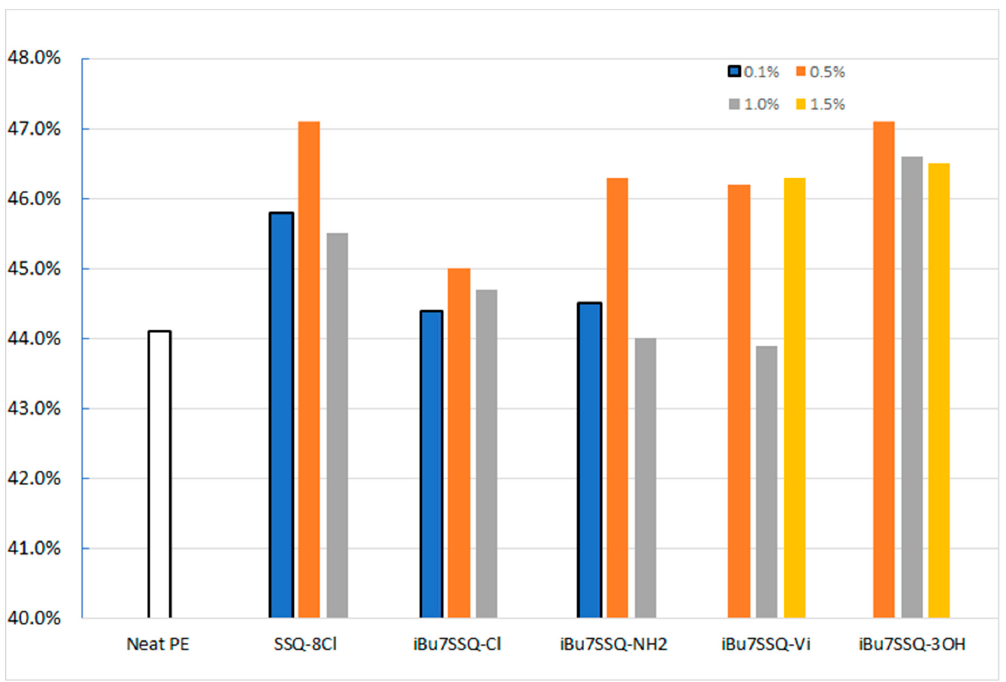
Figure 5. Crystallinity indices (CI) of the obtained composites.